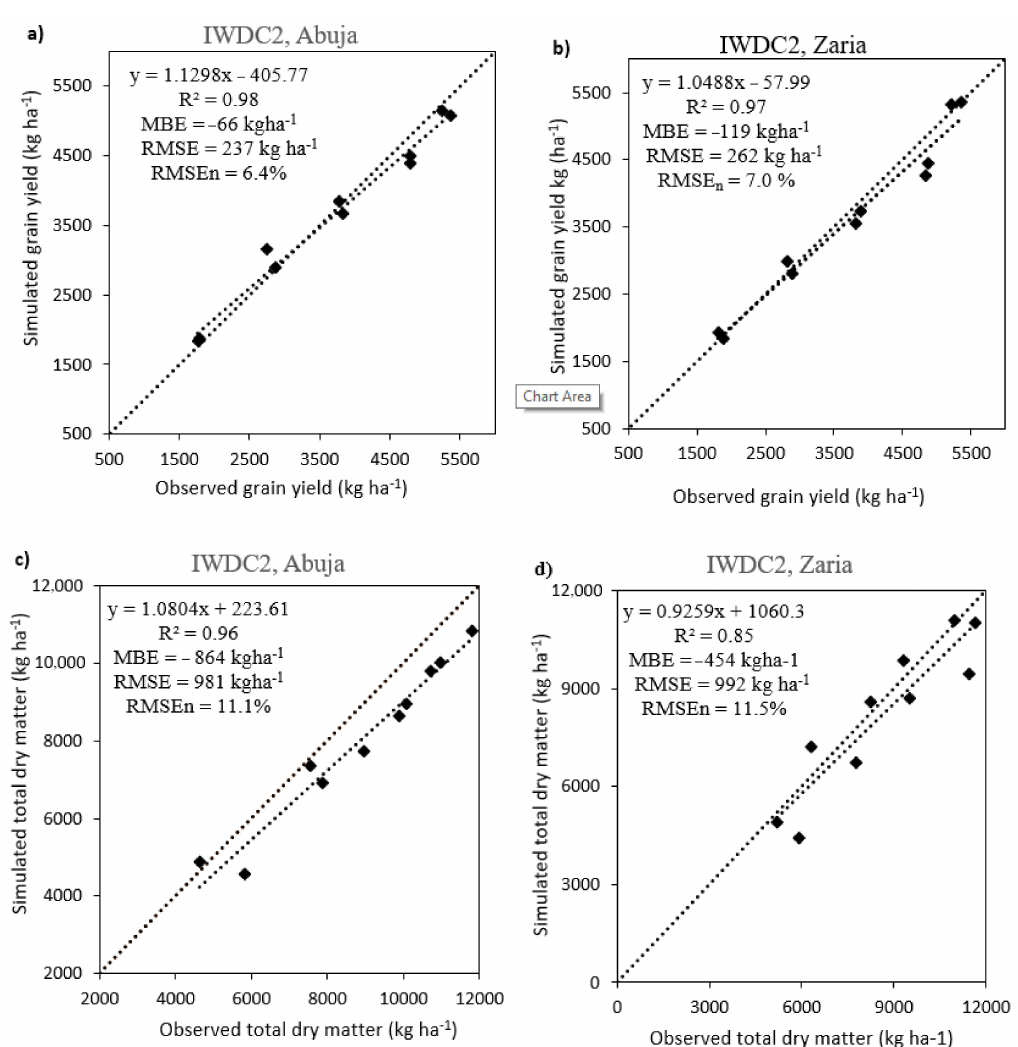
Figure 3. ( a – d )- Comparison of observed and simulated for grain yield and total dry matter (TDM) at across N–fertilizer applications in two growing seasons (2016 and 2017) at Abuja and Zaria for IWDC2SYNF2maize